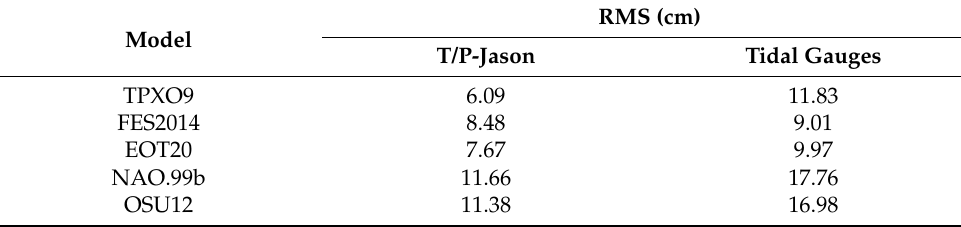
Figure 11. FCs of OBCs derived from model data TPXO9 ( a ), FES2014 ( b ), EOT20 ( c ), NAO.99b ( d ) and OSU12 ( e ). Table 4. RMS errors between observations and simulations with OBCs derived from large-scale tidal models.